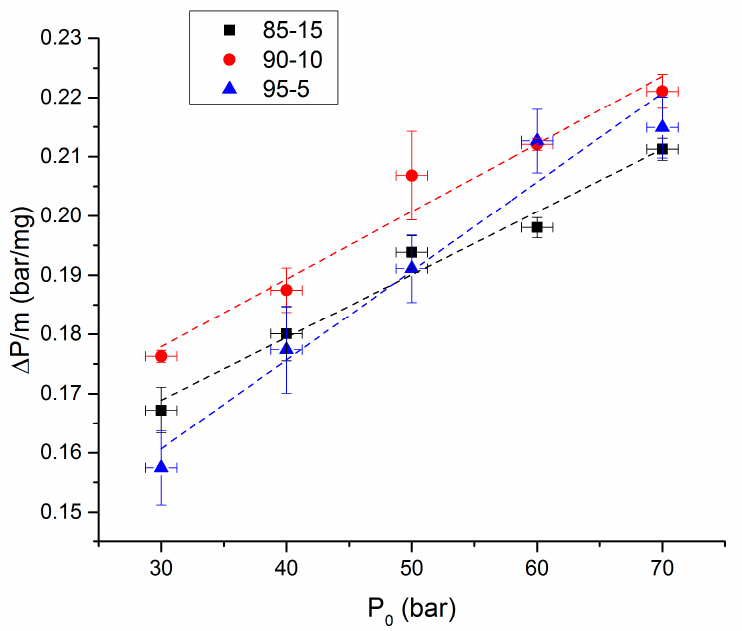
Molecules 2020 , 25 , x FOR PEER REVIEW Figure 6. Overpressures as functions of initial pressures under argon. Figure 6. Overpressures as functions of initial pressures under argon.